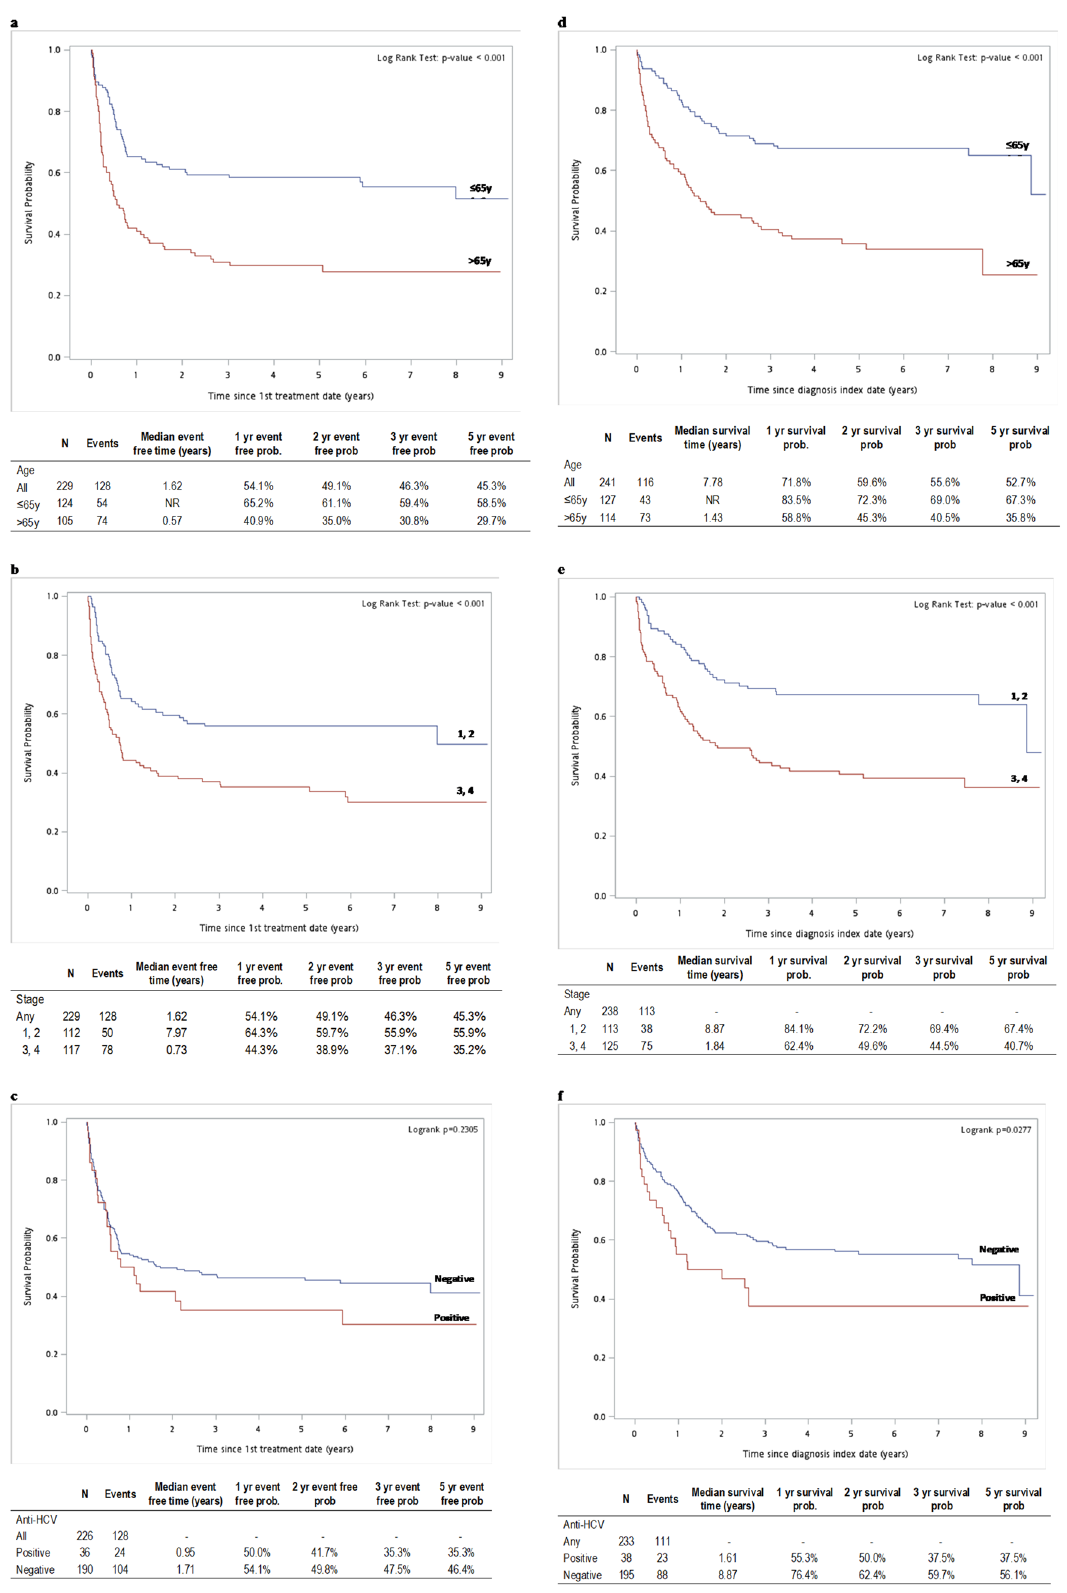
Figure 5. Survival in patients with DLBCL: median event-free time after the date of first treatment by ( a ) age, ( b ) stage at diagnosis, ( c ) anti-HCV antibody status. Overall survival after the diagnosis index date (death from any cause) by ( d ) age, ( e ) stage at diagnosis, ( f ) anti-HCV antibody